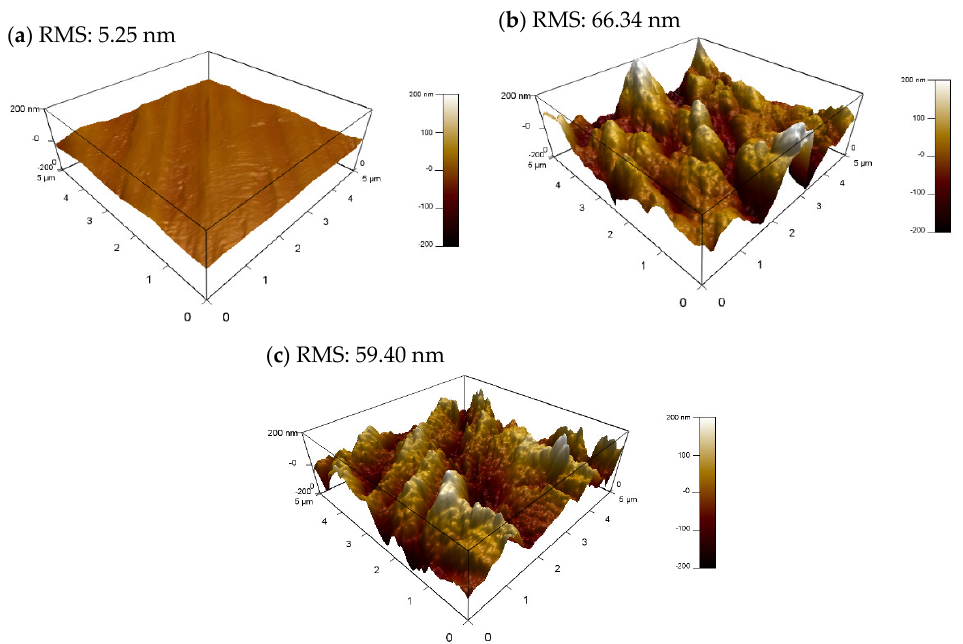
Figure 11. AFM images of ( a ) a polished C-steel coupon in the ( b ) absence and ( c ) presence of 2.22 mmol · L − 1 Q-22 inhibitor.